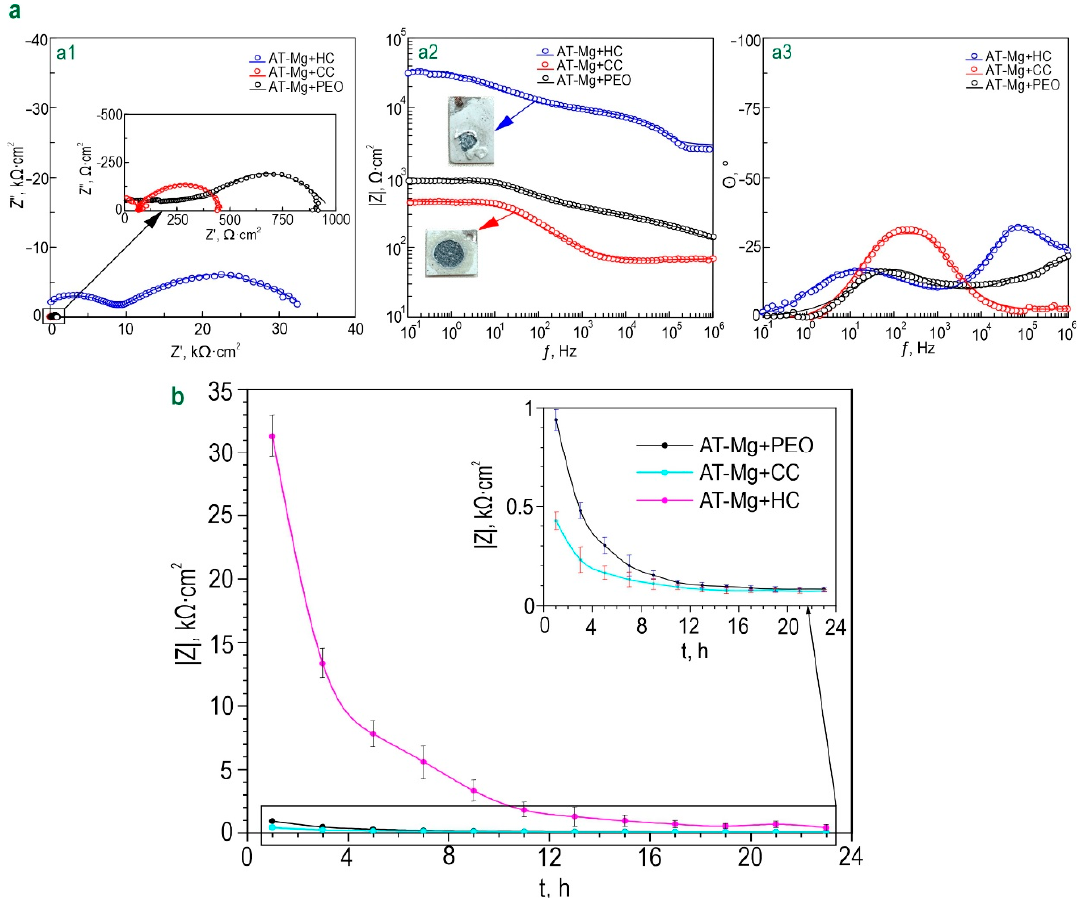
Figure 11. Impedance spectra presented in the form of Nyquist ( a1 ) and Bode plots ( a2 , a3 ), obtained after exposure of AT-Mg samples with various types of formed coatings to 0.9% NaCl for 1 h with optical images of samples after long-term (24 h) soaking in sodium chloride solution ( a ) and dynamics of change in the magnitude of impedance modulus, measured at a low frequency ( |Z| f =0.1Hz ), over exposure time of AT-Mg with different types of coatings to sodium chloride solution ( b ).